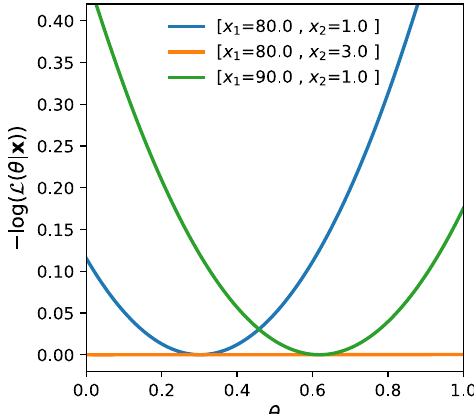
Fig. 9 Posterior densities predicted by the trained MDN for three pos- sible observations in the model of Sect. 5.3. When x 2 is small (blue and green curves), the value of x 1 gives sensitivity to the model parameter θ . When x 2 is large (orange curve), there is very little sensitivity to and the posterior is flat. (For visualization, all functions are offset to have a minimum of